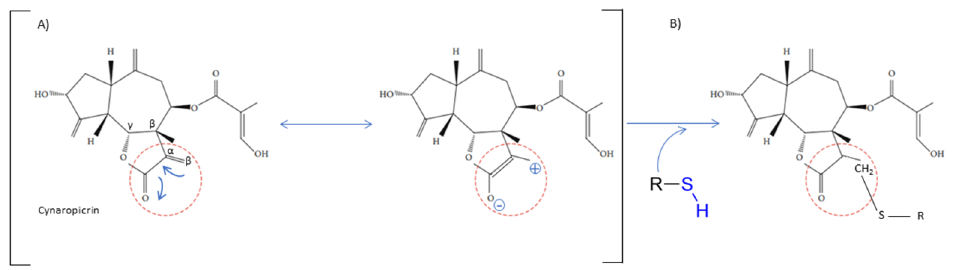
Figure 2. Cynaropicrin chemical structure, with the reactive center, α-methylene-γ-lactone moiety ( α M γ L). The reactive centers of SL are evidentiated with red circles. ( A ) Michael reaction between α-methylene-γ-lactone moiety (αM γL). ( B ) Reaction with a sulfhydryl group.